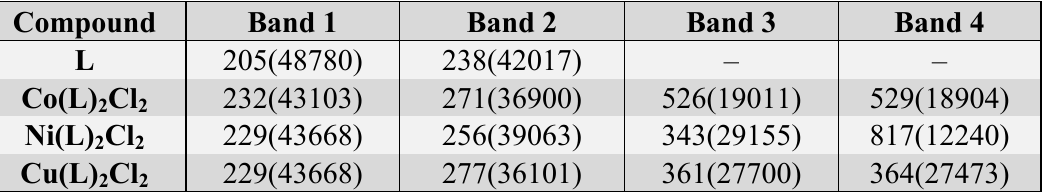
Table 3. Ultraviolet/visible spectral assignment of L and its metal complexes [wavelength, nm (cm − 1